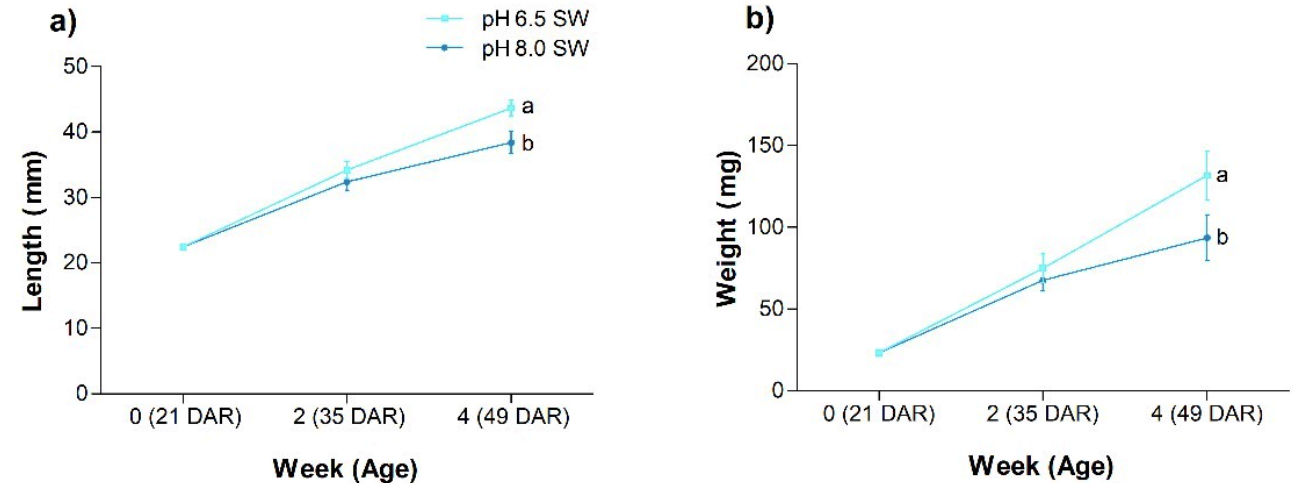
Figure 2. Trial 2—growth, ( a ) length and ( b ) weight (mean ± standard deviation) in 21 DAR seahorse juveniles H. reidi maintained for four weeks in SW at pH 6.5 and 8. Different letters indicate significant differences between pH levels at each age.